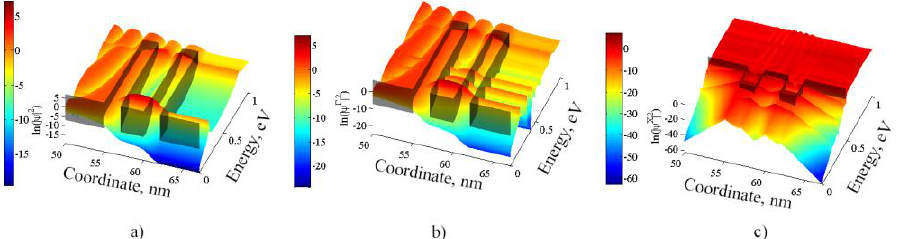
Fig. 1. The electron density probabilities calculated in the framework of the one-valley (a) and two-valley approximations (b — Г -valley, c —